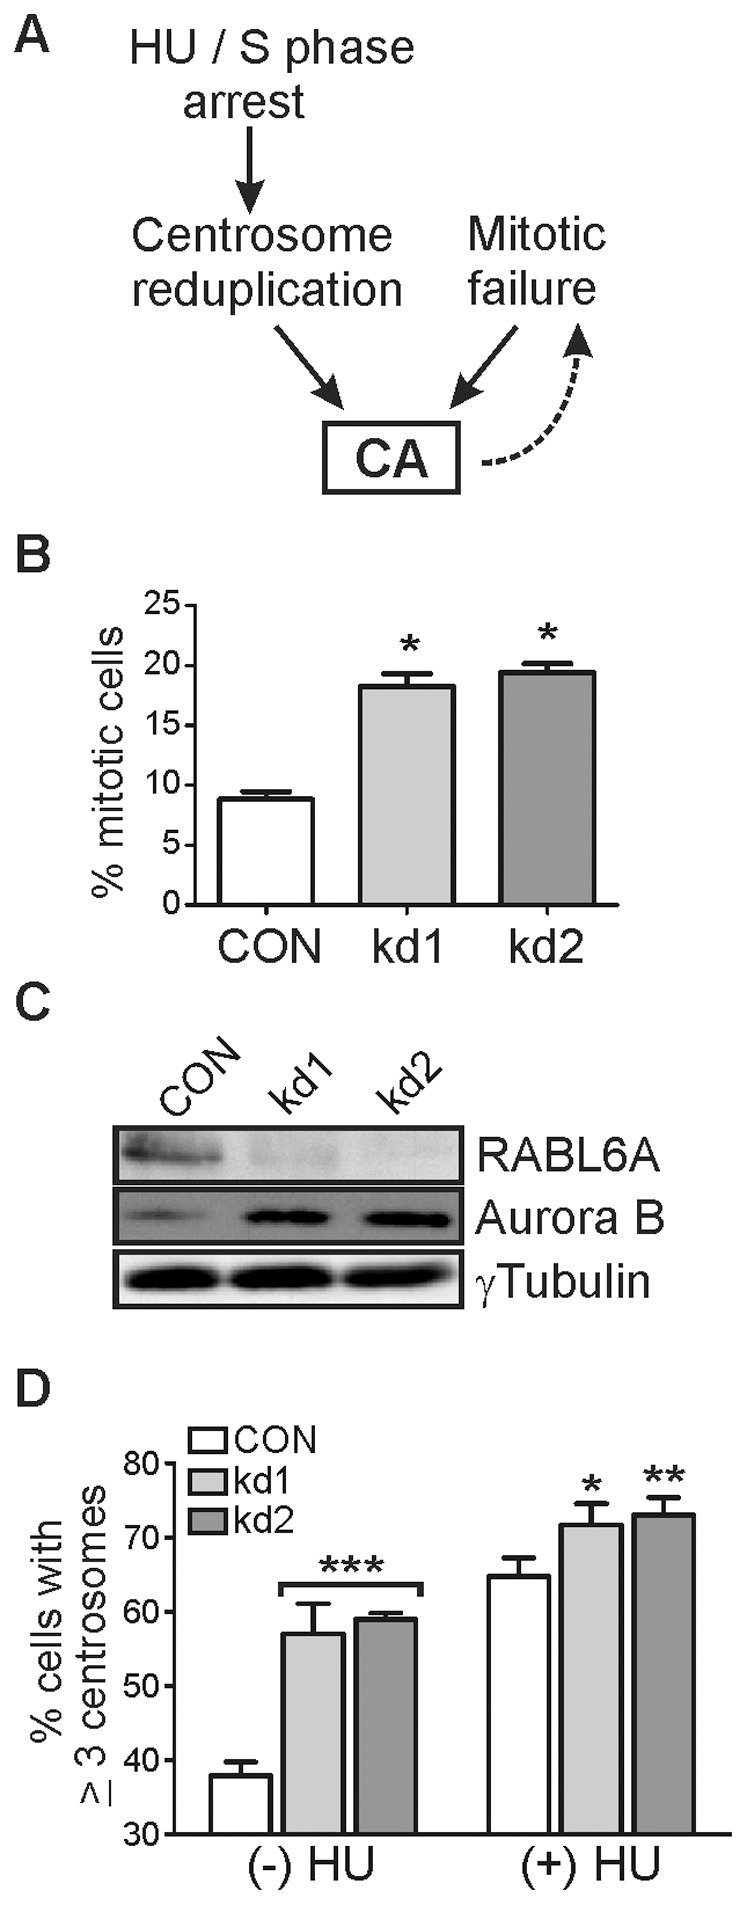
RABL6A depletion causes centrosome amplification by promoting centrosome reduplication.p53−/− MEFs were infected with CON, kd1 or kd2 shRNA viruses. (A) Schematic showing that centrosome reduplication and mitotic failure are two distinct causes of centrosome amplification (CA), whereas CA can lead to mitotic arrest and multinucleation. Hydroxyurea (HU) induces S phase arrest in cells, which in p53-negative cells leads to centrosome reduplication. (B) The percentage of mitotic cells following short-term nocodazole treatment was quantified for CON and RABL6A depleted cells. The mean and standard deviation from three separate experiments is presented (*, p<0.01 calculated by paired, two-tailed Student’s t-test). (C) Western blot analysis of RABL6A, Aurora B and γ-tubulin (loading control) showing increased levels of Aurora B in RABL6A knockdown cells. (D) Infected cells were treated without (−) or with (+) 2 mM HU for 40 hrs and centrosome numbers per cell quantified by immunofluorescence staining for γ-tubulin. Error bars represent the standard deviation from the mean from three independent experiments with statistical significance calculated using two-way ANOVA analyses (*, p<0.05; **, p<0.01; ***, p<0.001 for kd compared to CON cells).